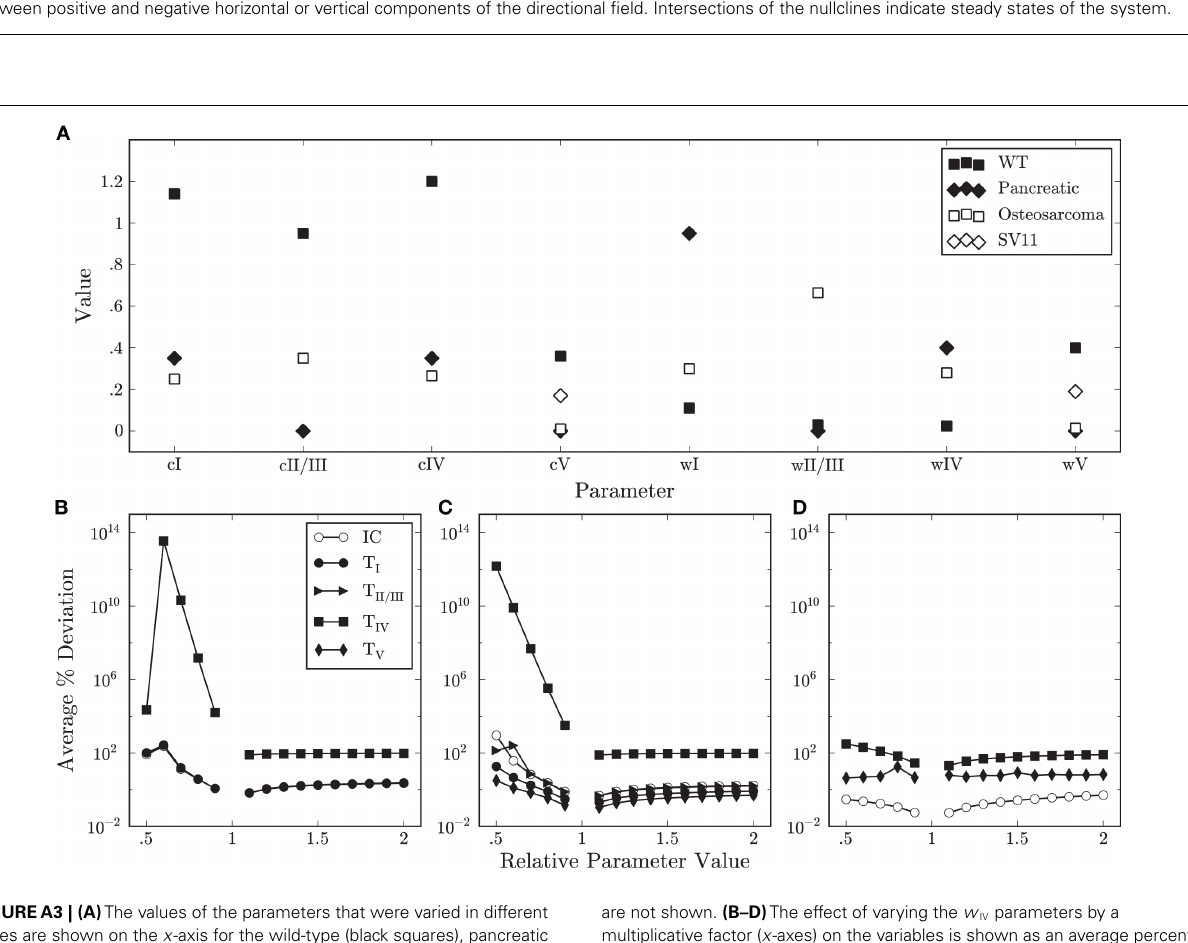
FIGUREA3 | (A) The values of the parameters that were varied in different cases are shown on the x -axis for the wild-type (black squares), pancreatic tumor (black diamonds), osteosarcoma (white squares), and brain tumor (white diamonds) models. n I fixes the value of n IV ( = 4 n I ) and n V ( = 0.3 n I ), and